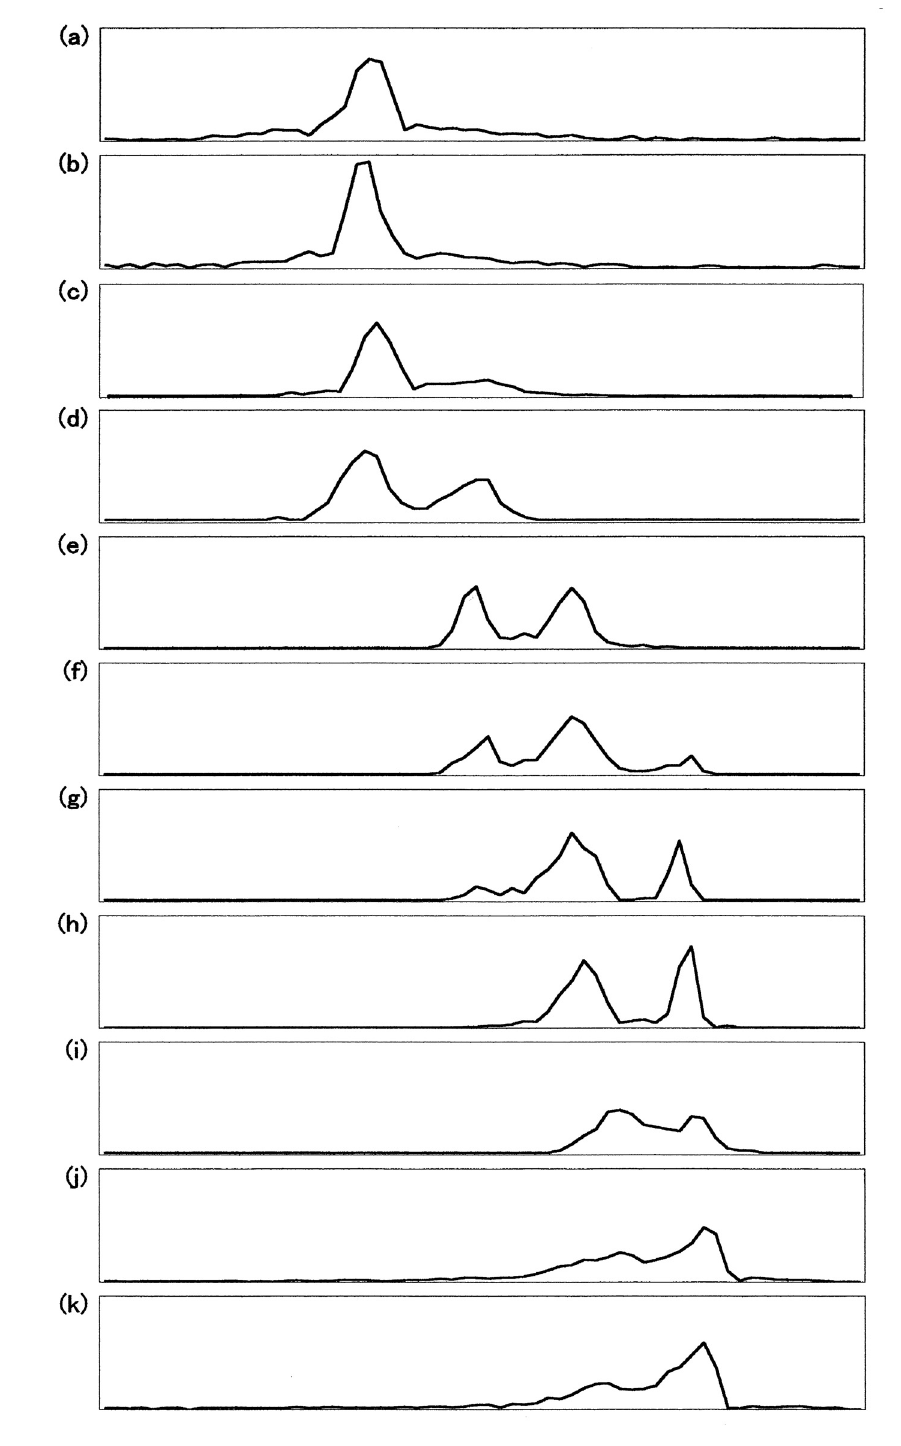
Figure 8. Densitometric profiles resulting from isoelectric-focusing electrophoresis by use of an image scanner. Each curve corresponds to the relevant column shown in Figure